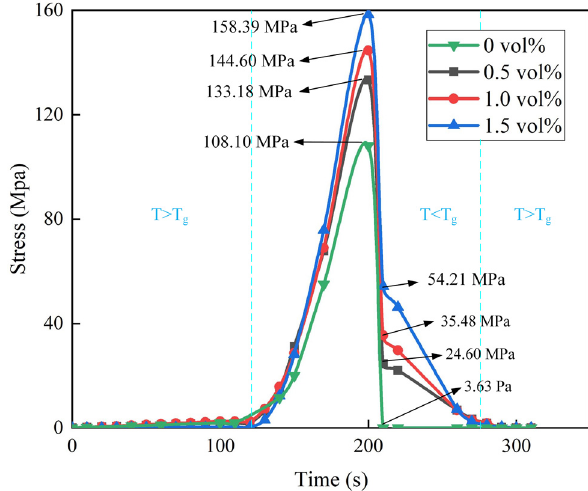
Figure 11: Stress distribution of SMGO/EP with di ff erent GO